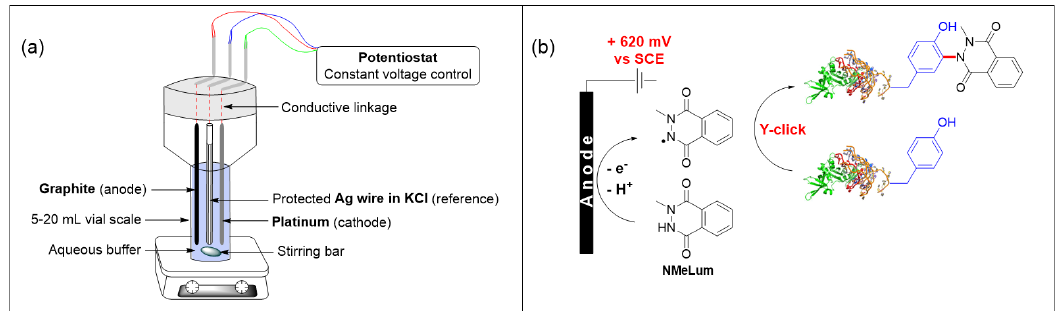
Figure 22. ( a ) Three-electrodes system connected to a potentiostat used for constant voltage experiments. ( b ) NMeLum radicals are in situ progressively generated at the anode surface and further react with exposed Y from biomolecules.